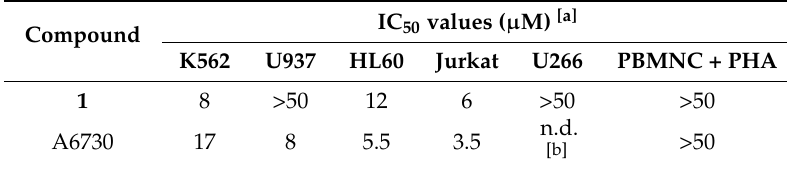
Table 1. In vitro activity of compound 1 on U937, K562, HL60, Jurkat, and U266 cells, and cytotoxicity on human peripheral blood mononuclear cells PBMNC +